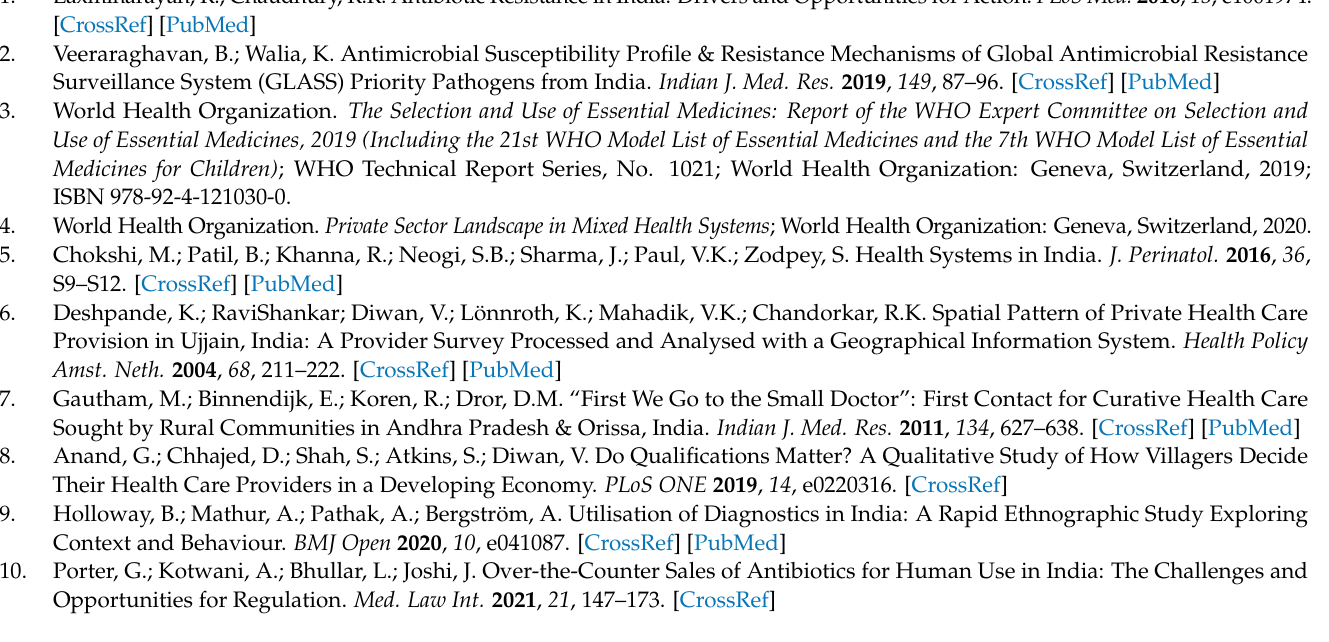
Table S6. Distribution of antibiotic prescription at outpatient visit across age groups in years and WHO ATC class in Defined Daily Doses (DDD); Table S7. Distribution of patient reported antibiotic use after outpatient visit across age groups in years and WHO ATC class in Defined Daily Doses (DDD).; Table S8. Distribution of antibiotic encounters for all 1000 patients by presumptive diagnosis and AWaRe category, in encounters and percentages; Table S9. Distribution of antibiotics for all patients prescribed antibiotics at outpatient visit by presumptive diagnosis and ATC class in defined daily doses